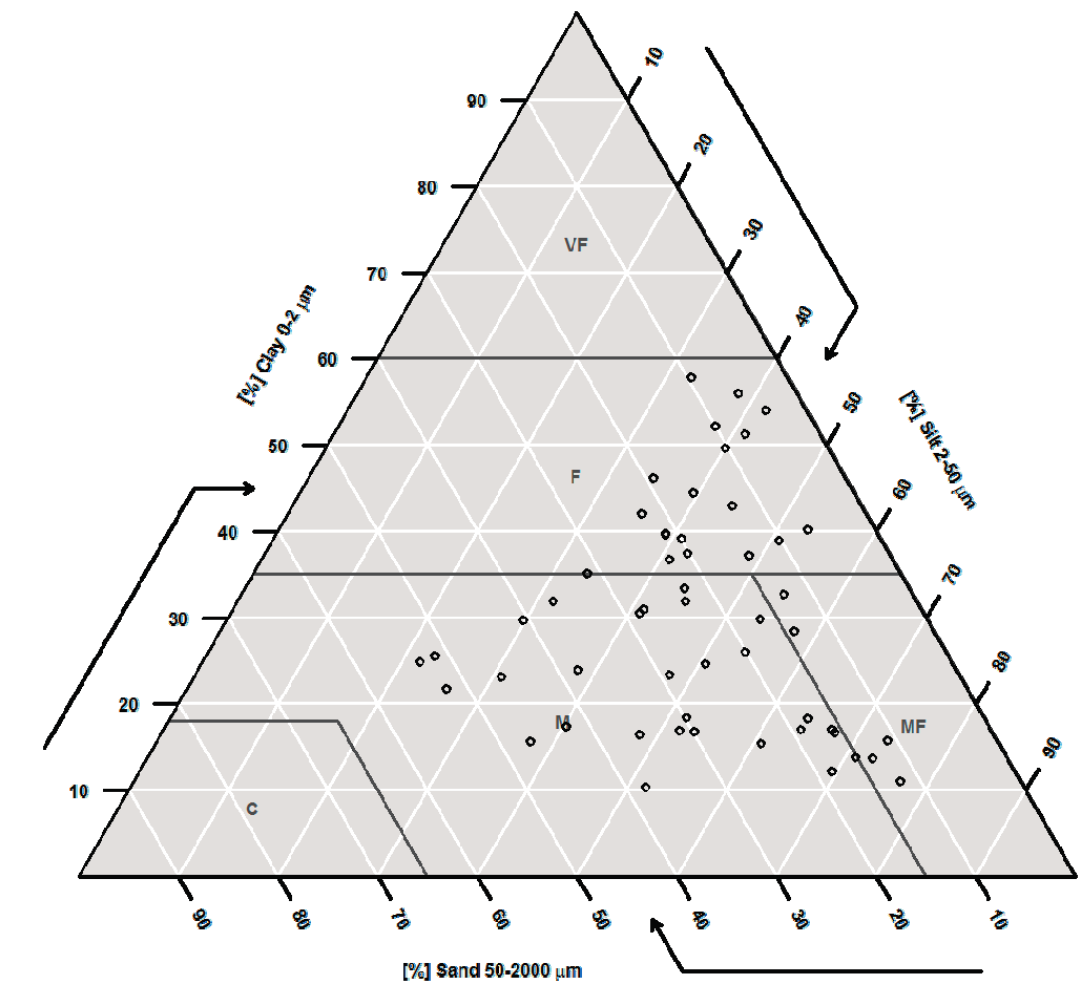
Figure 2. Distribution of the 57 soil texture measurements inside the textural triangle as defined by the European Soil Map (HYPRES) texture classification system. The triangle is divided in five classes: Very Fine (VF), Fine (F), Medium Fine (MF), Medium (M) and Coarse